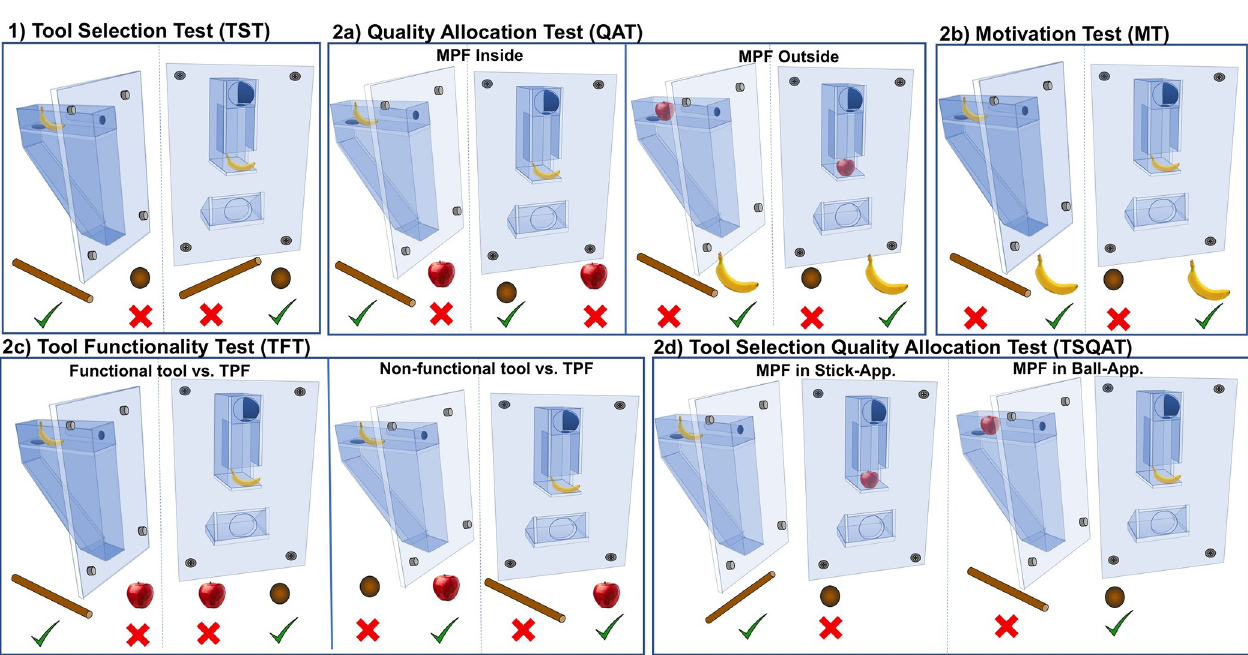
Fig 2. Overview of the conditions within each of the five tests. High quality food is banana-pellet, lower quality food is apple. 1) TST (Tool selection test): both tools are present while the high quality food is inside the apparatus. 2a) QAT (Quality allocation test): the tool is functional in each of the conditions. Left: High quality food is inside the apparatus. Immediate food option is the lower quality food. Right: Lower quality food is inside the apparatus. The high quality food is the immediate food option. 2b) MT (Motivation test): tool is always functional. High quality food is inside and outside the apparatus. 2c) TFT (Tool functionality test): High quality food is inside the apparatus in each condition. Left: Functional tool is present. Right: Non-functional tool is present. 2d) TSQAT (Tool selection quality allocation test): both tools and both apparatuses are present. Left: High quality food is located in the stick-apparatus. Right: High quality food is located in the